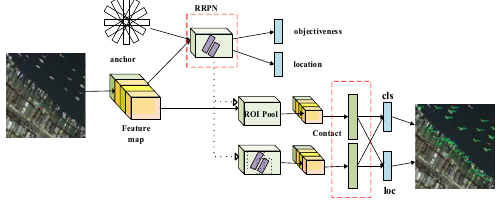
Figure.1 The proposed network